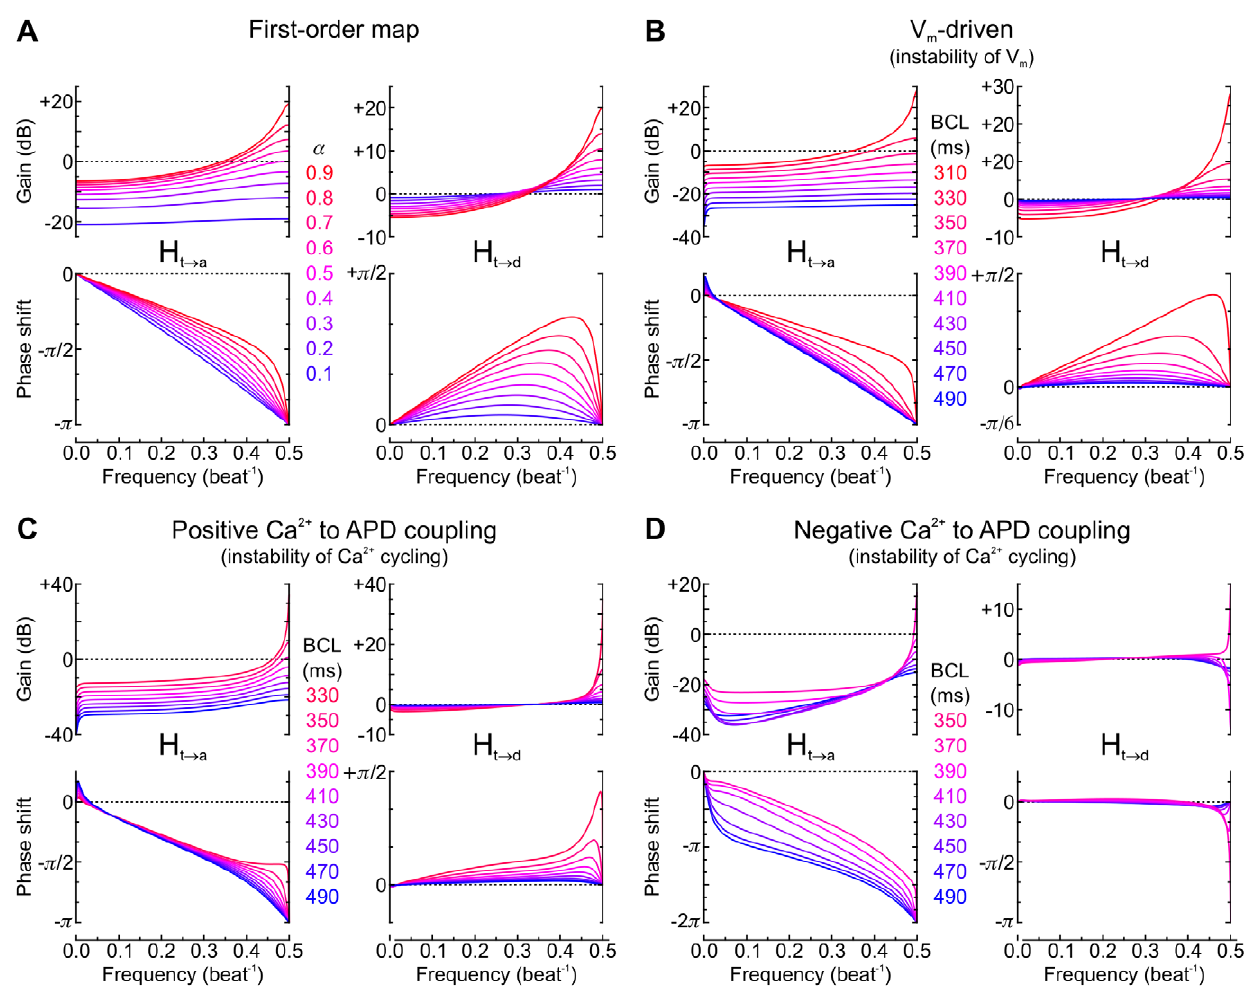
Figure 5. Aspect of the transfer functions at regimes closer and closer to the bifurcation to alternans. A : Transfer functions H t R a and H t R d in a theoretical first-order memoryless model given by APD n = f (DI n 2 1 ), with a being the slope of f . B , C and D : Transfer functions H t R a and H t R d in the three versions of the Sato et al. model, computed by eigenmode analysis at various BCLs.